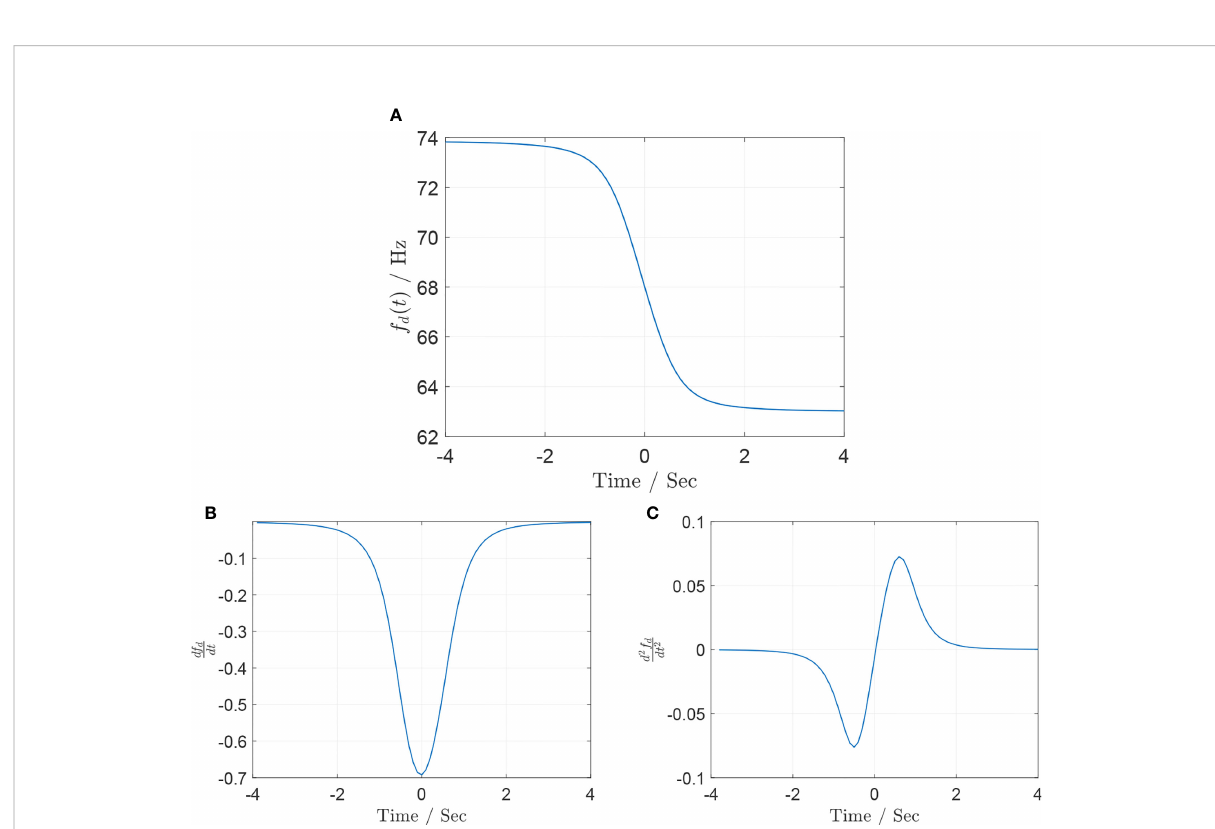
FIGURE 5 (A) Doppler shift curve f d ( t ), assuming f v = 123 m/s, h = 200 m, d = 50 m, and wmin = 30. (B) Doppler shift curve f d ( t ), assuming 0 = 68 m/s, v = 123 m/s, h = 150 m, d = 20 m, and wmin = 30. (C) Doppler shift curve f d ( t ), assuming f f 0 = 68 m/s, d = 20 m, and wmin =